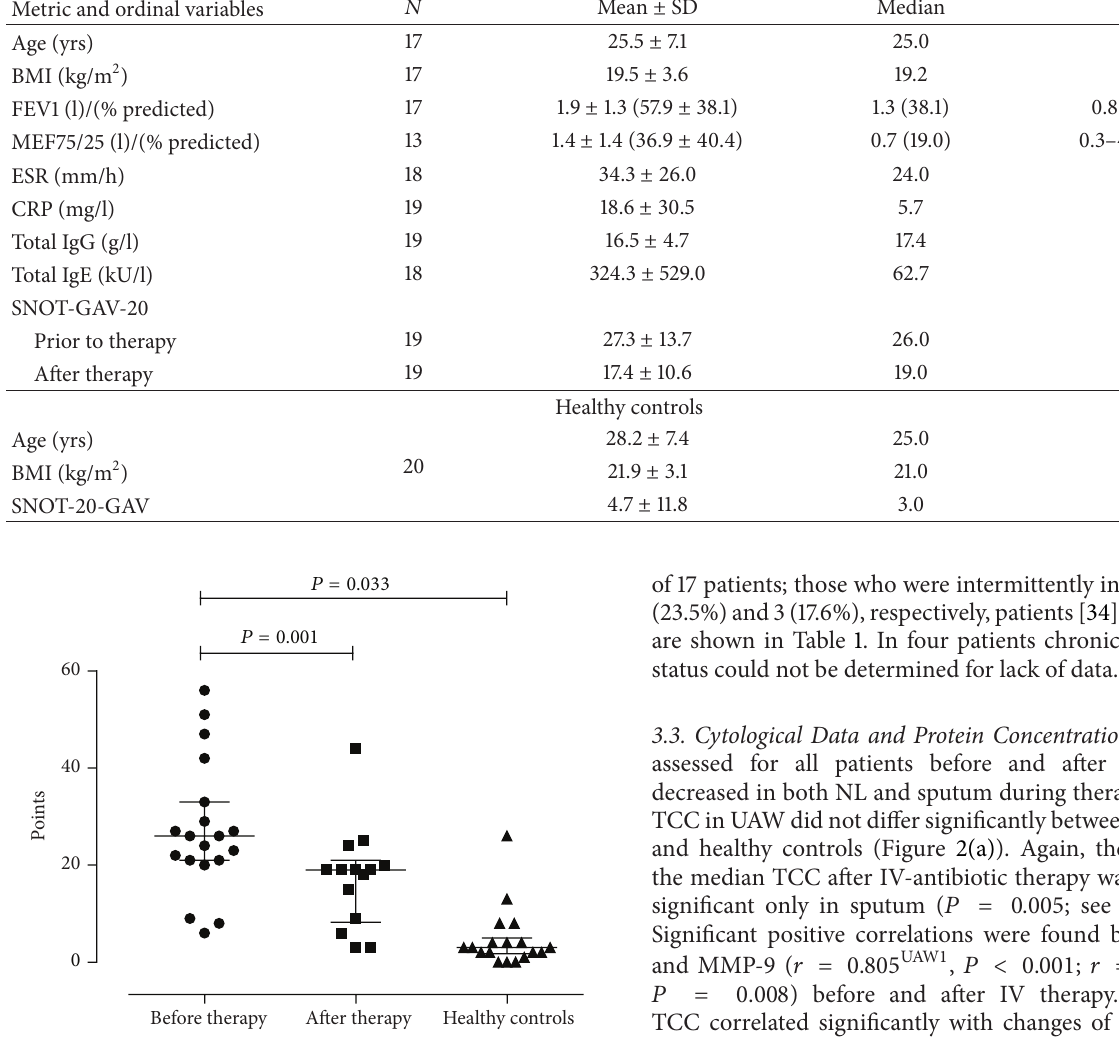
Figure 1: Comparison of SNOT-20-GAV scores before and after IV- antibiotic therapy in CF and in healthy controls. In CF a significant decrease was shown during therapy from a median of 26 points to 19 points ( 𝑃 = 0.001 ) which was still elevated (n.s.) compared to healthy controls (median: 3